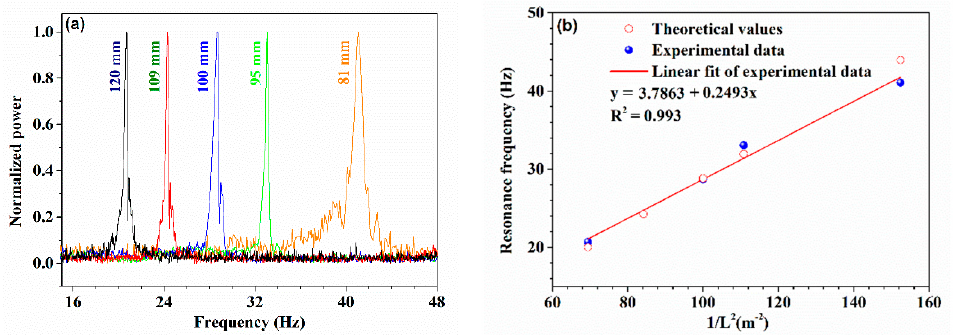
Figure 10. ( a ) Normalized power spectra with different cantilever lengths. ( b ) Fundamental frequencies as a function of cantilever lengths